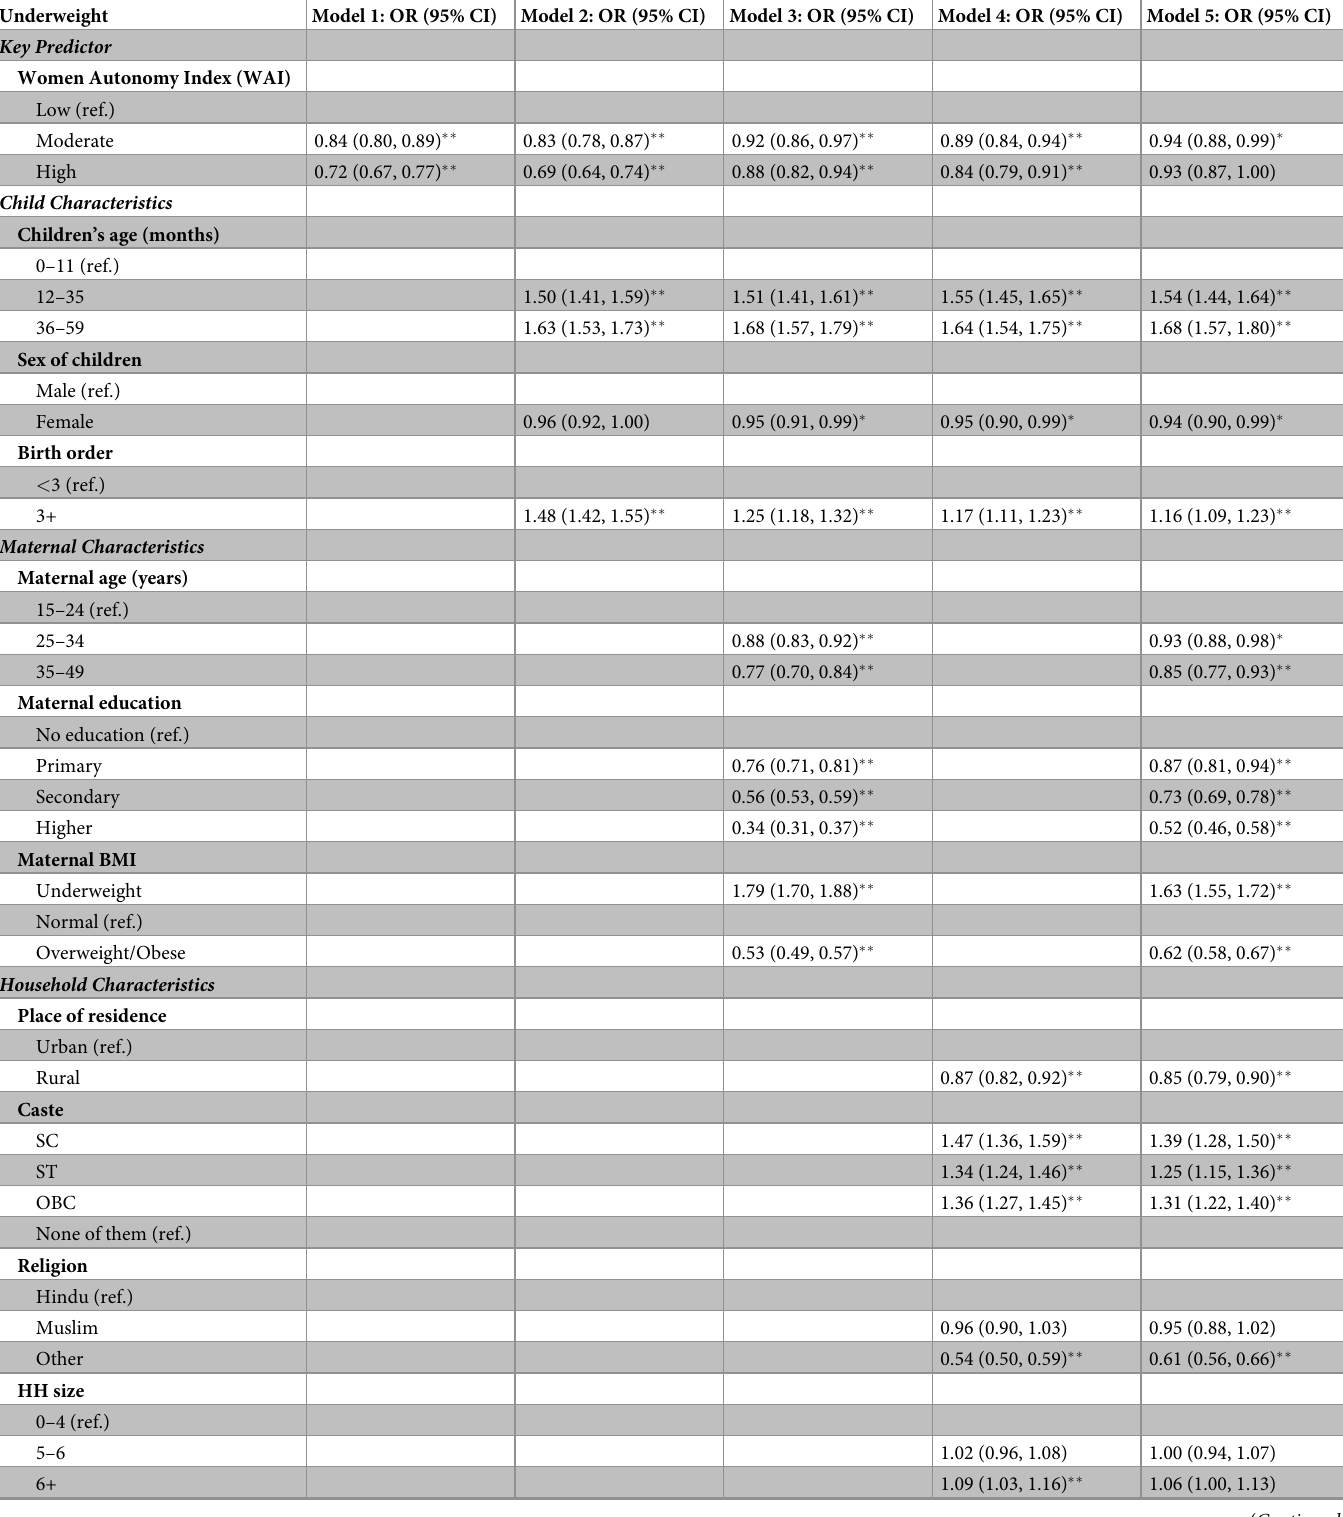
Table 5. Binary logistic regression models assessing the association between maternal autonomy and underweight among under-five children, NFHS-4 (2015–16).